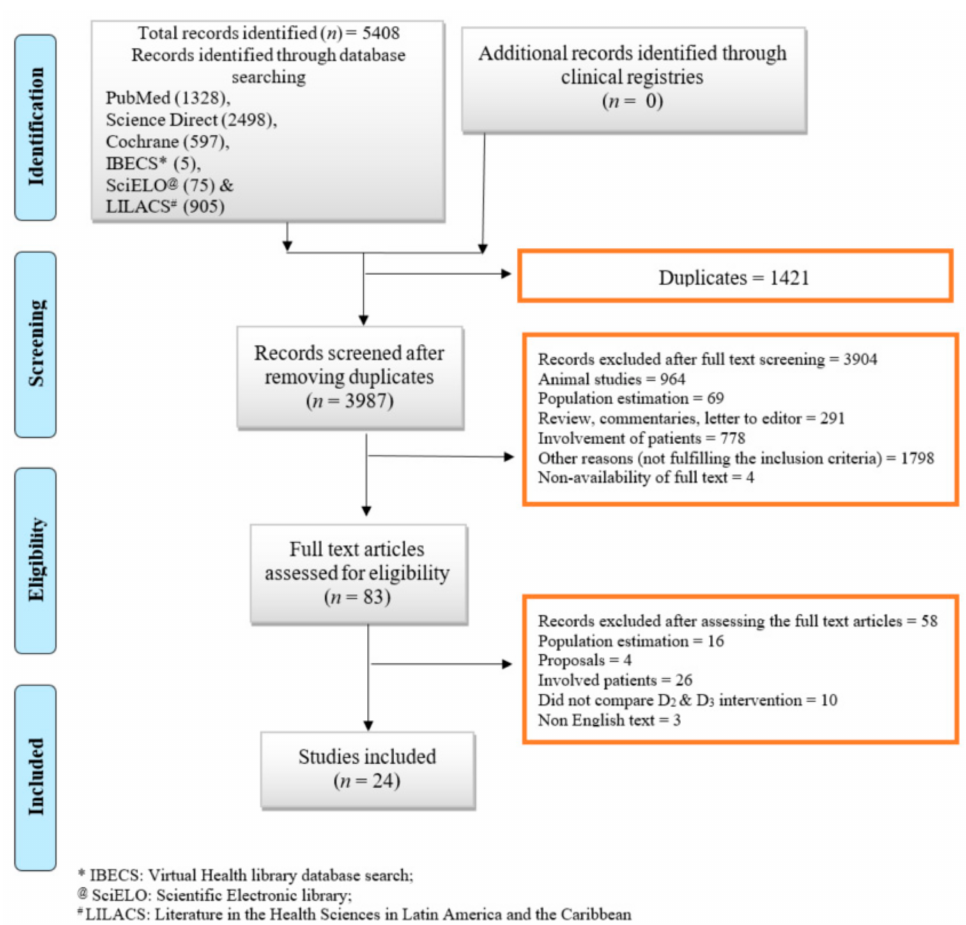
Figure 1. Flow diagram as per PRISMA recommendations. Legend: The flow chart illustrates the number of articles included and excluded at various